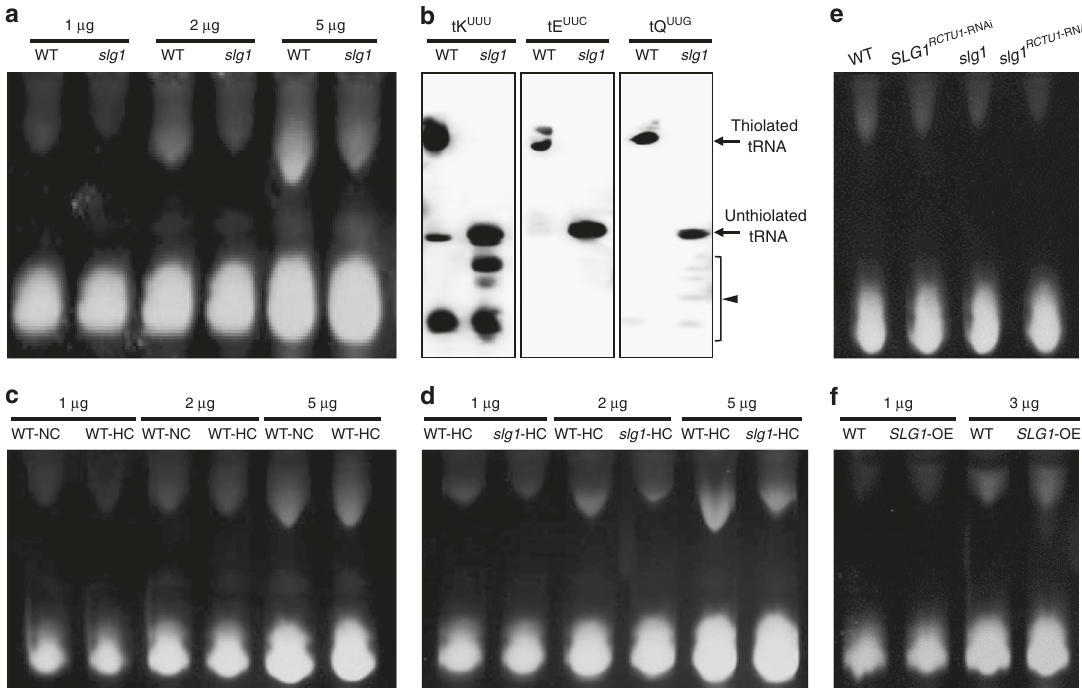
Fig. 2 SLG1 -mediated thermotolerance is positively correlated with thiolated tRNA level. a Comparison of thiolated tRNA level between slg1 and WT. Shoots of 2-leaf-stage seedlings under normal conditions were sampled. The slow-migration band indicates thiolated tRNAs in the presence of APM. The loaded amount of tRNA was 1, 2, and 5 µ g for each lane, respectively. b Northern blot analysis. The loaded amount of tRNA was 1 µ g, which was extracted from 2-leaf-stage normal-grown seedlings. Three tRNA isoacceptors of tK UUU , tE UUC , and tQ UUG were used to detect the speci fi cally thiolated tRNAs. The bands observed in tK (arrowhead) might be indicative of tRNA halves or tRNA degradation. c tRNA thiolation process was adversely affected by high- temperature stress. Shoots of 2-leaf-stage seedlings grown under high-temperature (45 °C, 44 h) and normal conditions were sampled, respectively. The loaded amount of tRNA was 1, 2, and 5 µ g for each lane, respectively. NC, normal conditions; HC, high-temperature conditions. d – f Comparison of thiolated tRNA level. Shoots of 2-leaf-stage seedlings under high-temperature (45 °C, 44 h; g ) or normal conditions ( h , i ) were sampled, respectively. The loaded amount of tRNA was 1, 2, and 5 µ g ( d ), 3 µ g ( e ), 1 and 3 µ g ( f ) for each lane, respectively. The experiments in ( a – f ) were repeated three times with similar results. Source data are provided as a Source data fi (Supplementary Fig. 6a – c). To study if RCTU1 works in the same genetic pathway as SLG1, we constructed RCTU1 -RNAi trans- genic plants under the background of WT ( SLG1 RCTU1 -RNAi ) and slg1 ( slg1 RCTU1 -RNAi ), respectively. We found that both SLG1 RCTU1 -RNAi and slg1 RCTU1 -RNAi transgenic plants showed